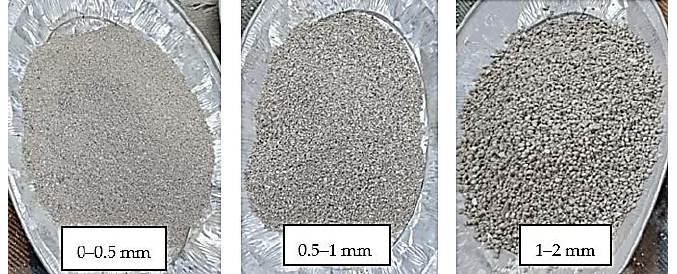
Figure 6. Plastering mortar waste divided into each grain size.